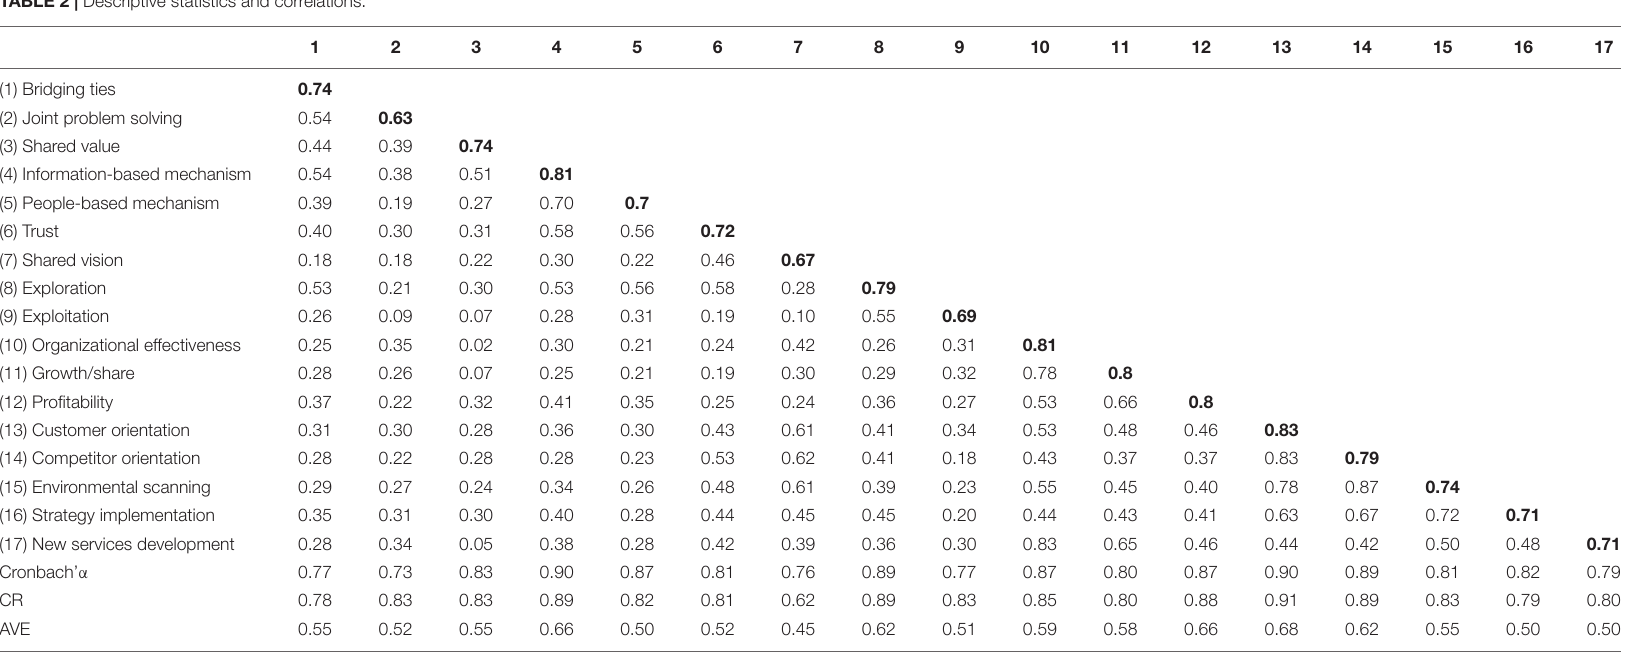
TABLE 2 | Descriptive statistics and